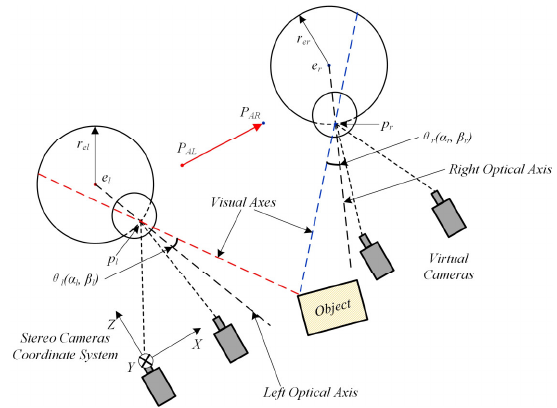
Figure 6. The diagram of the 3D eye model and the definition of the eyeball features. All the 3D points refer to positions in the device coordinate system (as the stereo cameras coordinate system shown in the figure). The 3D point-of-regard is considered as the intersection point of the left and right eyes’ visual